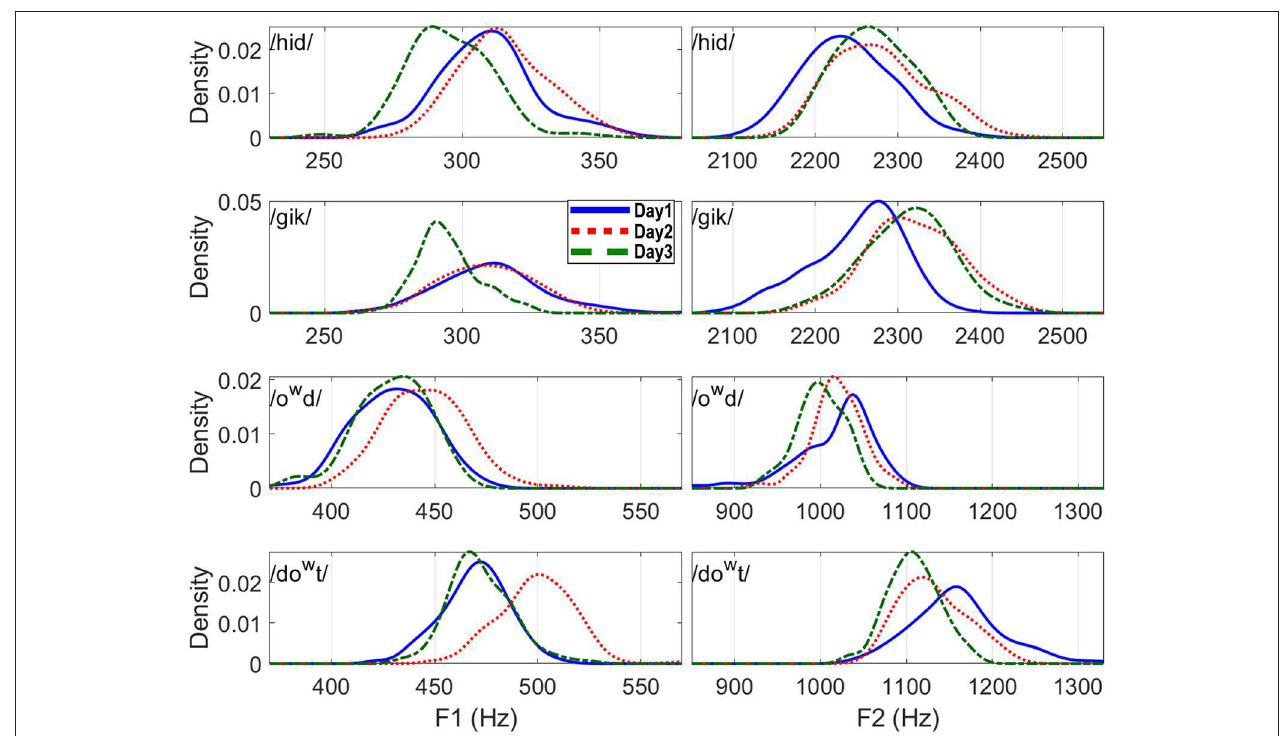
FIGURE 2 | F1 and F2 distributions for the four words (measured at the vowel midpoint) separately for each day.